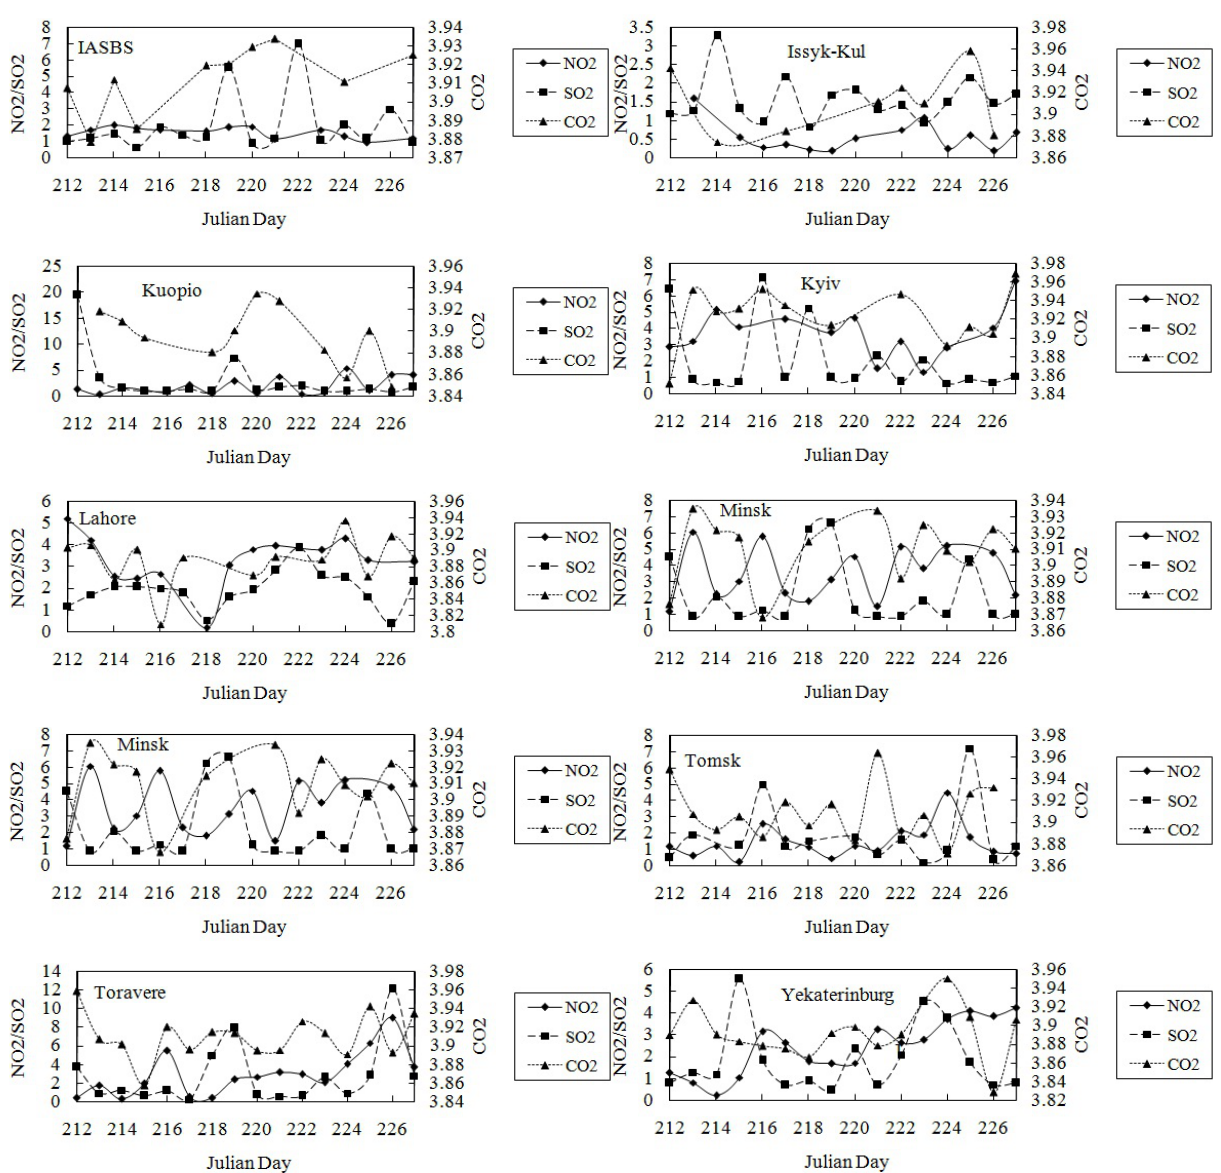
Fig. 7. Time series of the concentrations of NO 2 , SO 2 and CO 2 in different countries. The CO 2 , NO 2 and SO 2 concentrations are expressed in ppmv (partspermillionbyvolume), moleccm 2 , and D.U., respectively. To make appropriate comparisons, all CO 2 values were divided by 100, all NO 2 were divided by 10 15